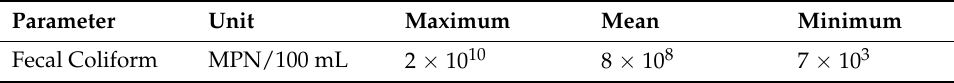
Table 3. The concentration of FC in wastewater discharge.